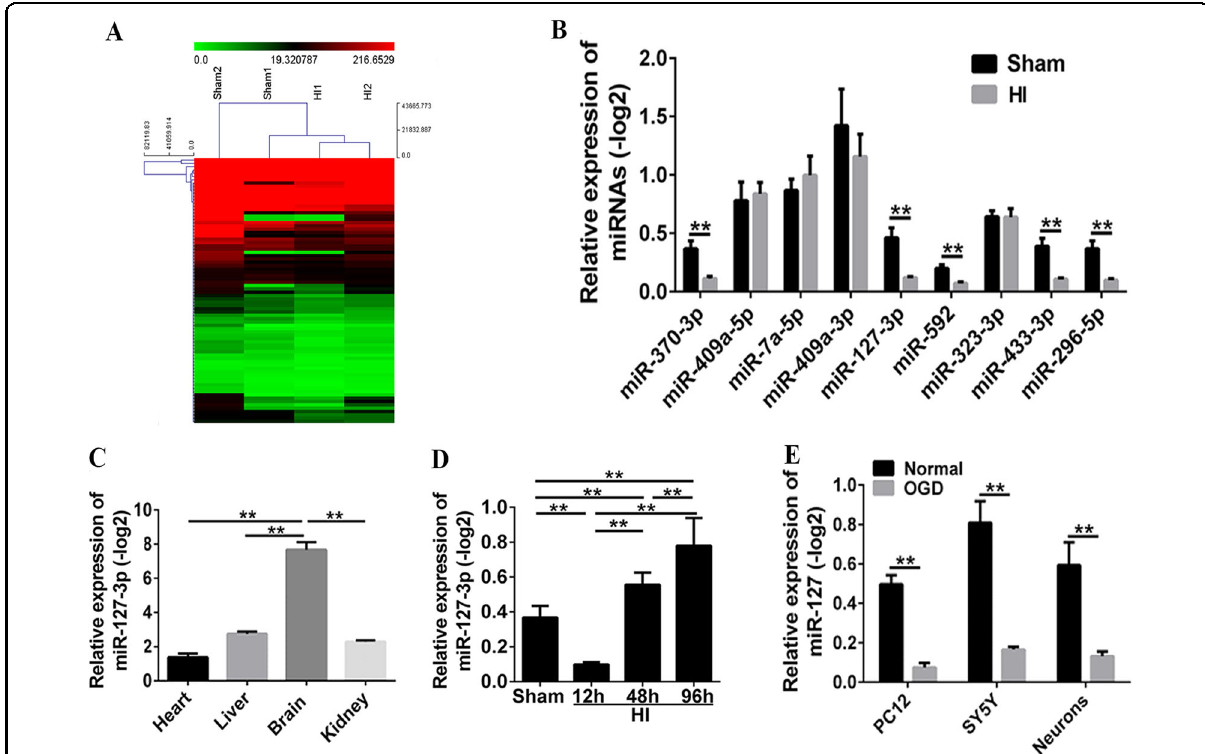
Fig. 1 The speci fi c expression of miR-127-3p in vivo and in vitro. A Results of miRNA sequencing analysis showed that the expression of miRNAs in sham and HI have obvious difference ( n = 2/group). B The qRT-PCR validation of differential miRNAs in normal group rats and HI group rats at 12 h after HI injury. Each bar was the mean ± s.d. relative to − log2 (** P < 0.01 with Student ’ s t -test, n = 6). C Relative expression of miRNA-127-3p in heart, liver, brain, and kidney of rats. MiRNA-127-3p was selectively highly expressed in the brain (** P < 0.01 with one-way ANOVA, n = 6). D qRT-PCR analysis of miR-127-3p expression at 12, 48, and 96 h. MiRNA-127-3p decreased at 12 h after HI, while it increased at 48 and 96 h after HI injury (** P < 0.01 with one-way ANOVA, n = 6). E The relative expression of miR-127-3p in OGD of PC12, SY5Y, and neurons was signi fi cantly decreased in vitro (** P < 0.01 with Student ’ s t -test, n = 6). HI hypoxic